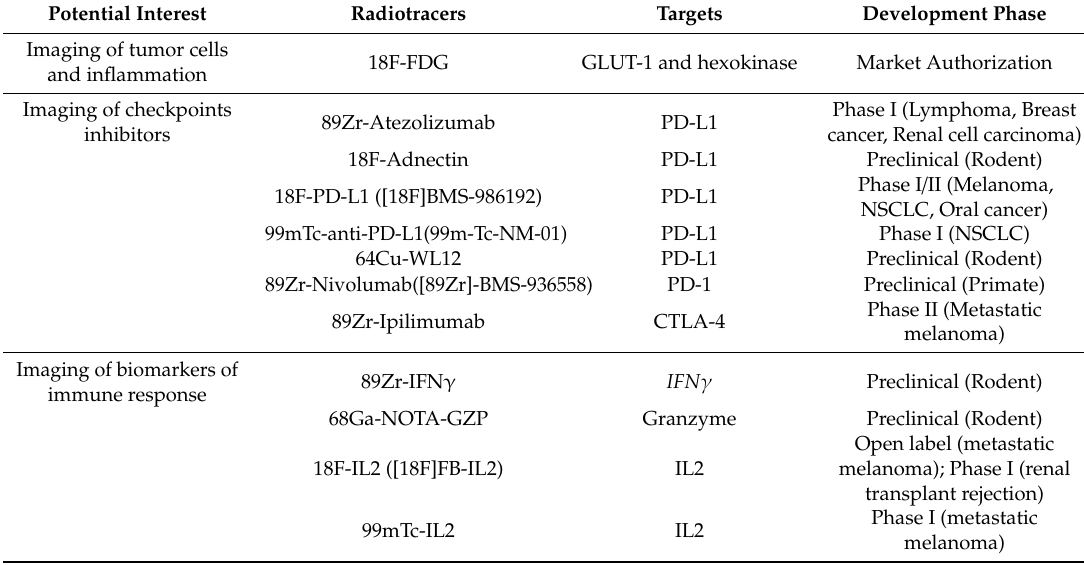
Table 1. Radiotracers studied in the context of immunotherapy with potential interest,